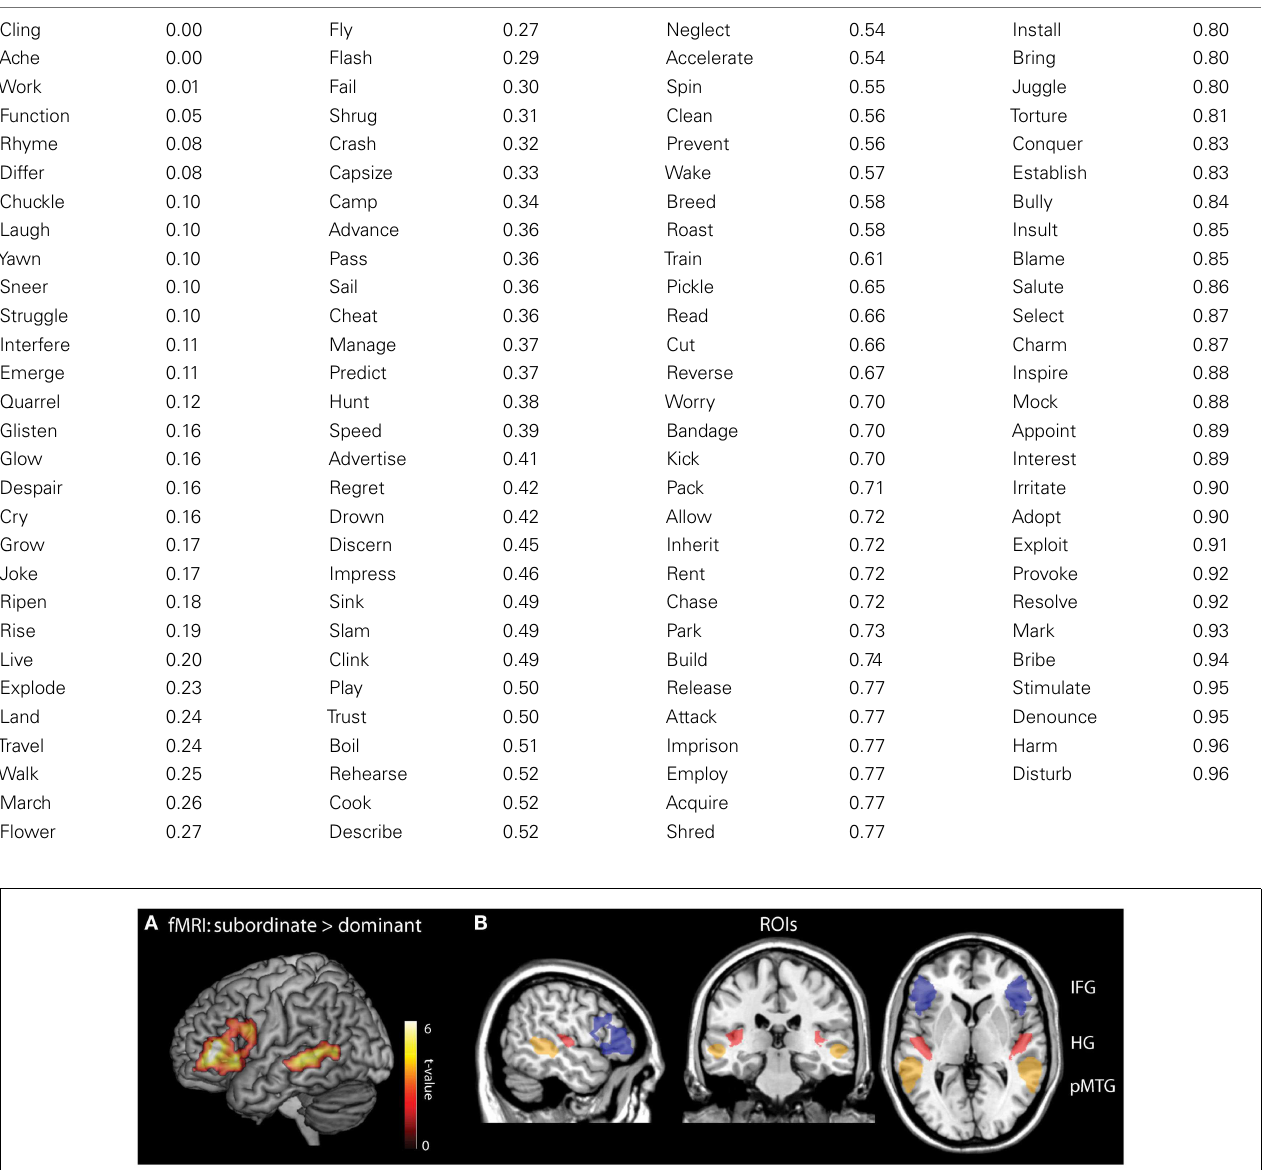
included the fMRI defined LIFG (blue) and LpMTG (orange) with the anatomically defined Heschl’s gyrus (red). Each region also has a right hemisphere